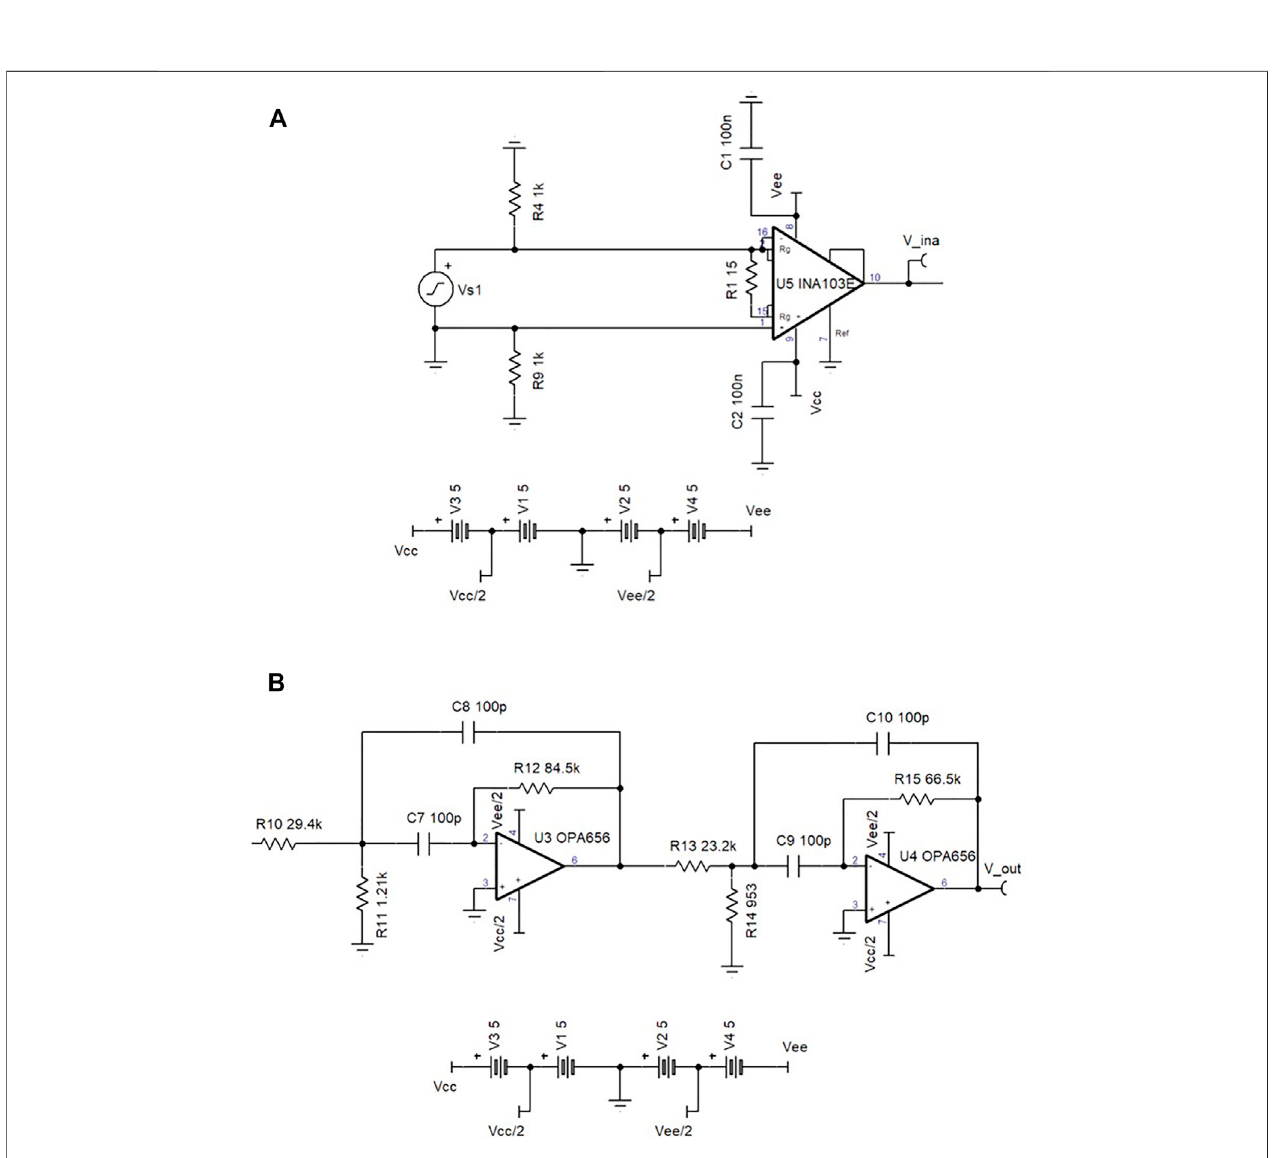
FIGURE 3 | (A) The circuit diagram for the custom LNA design using TINA software from Texas Instruments. (B) The circuit diagram for the 4th order butterworth fi lter used at the output of the LNA.